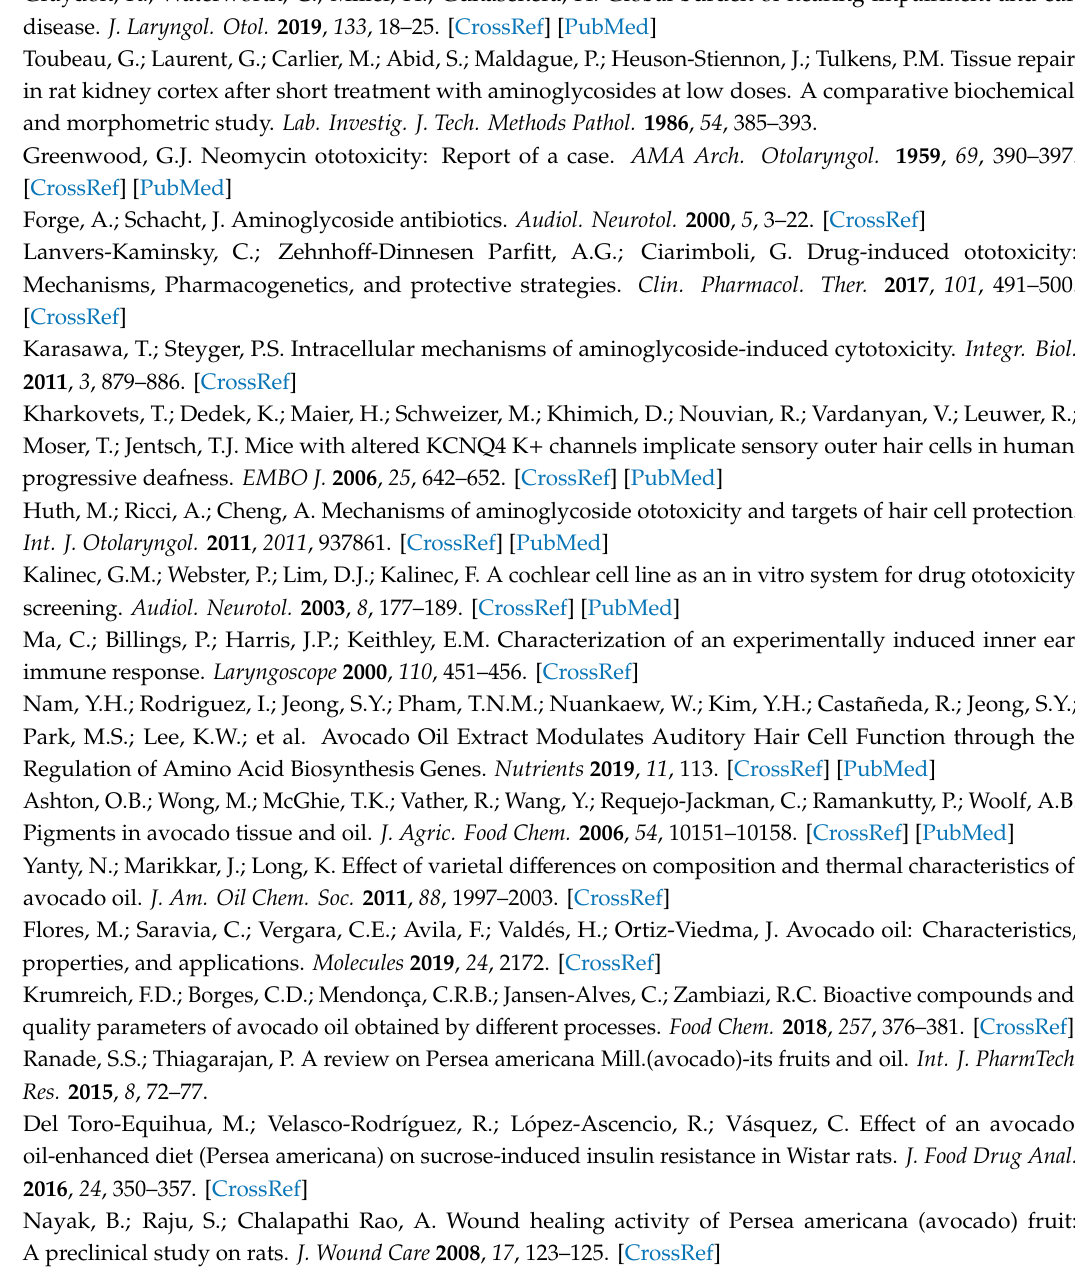
Figure S1: E ff ect of DKB122 alone treatment on HEI-OC1 cells. Figure S2: DKB122 suppresses inflammatory gene expression in normal ear cells. Table S1: Primer sequences for